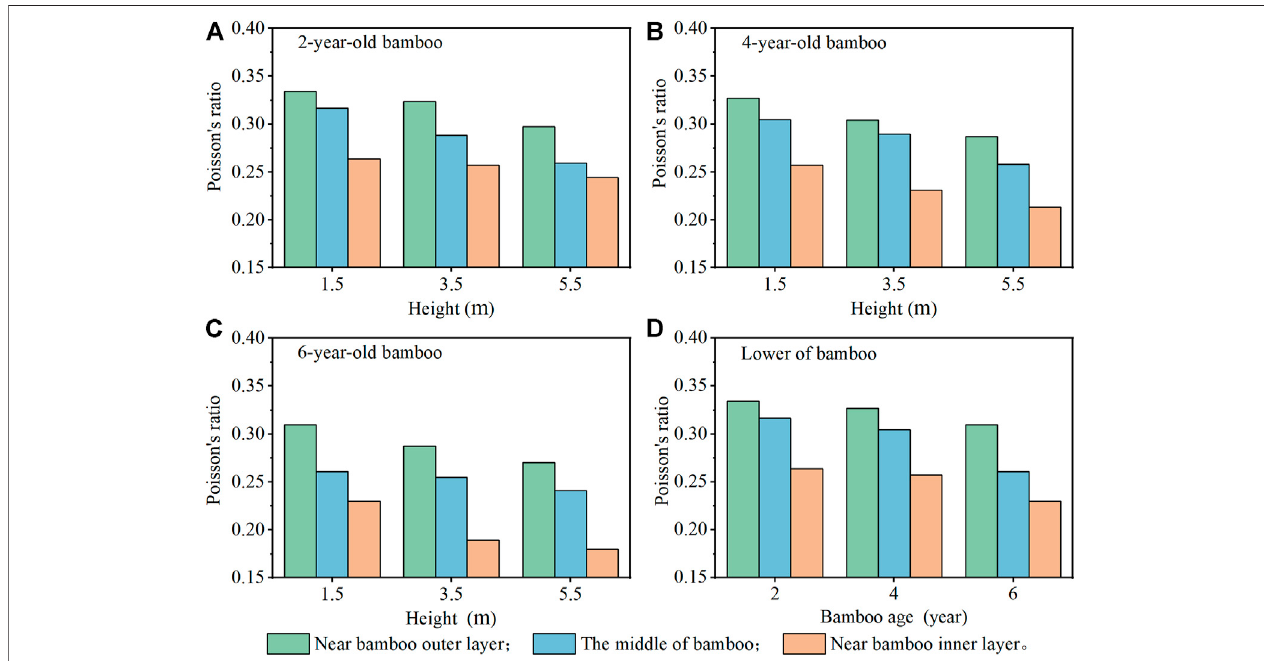
FIGURE 2 | Bamboo Poisson ’ s ratio variation graphs: (A) 2-year-old bamboo; (B) 4-year-old bamboo; (C) 6-year-old bamboo; (D) Lower of bamboo.